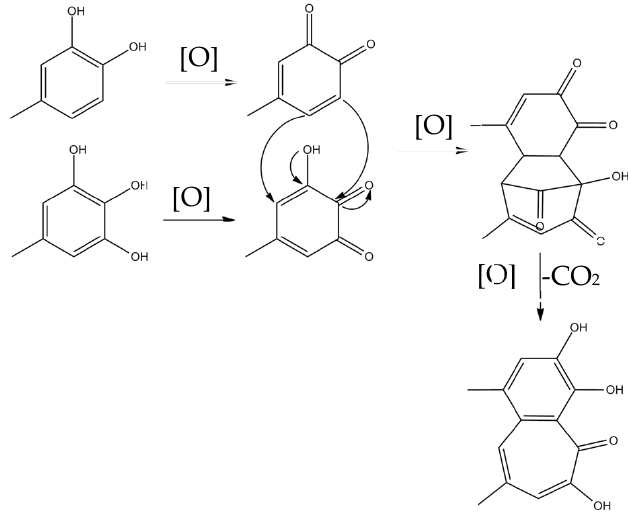
Figure 3. The formation pathway of theaflavins.